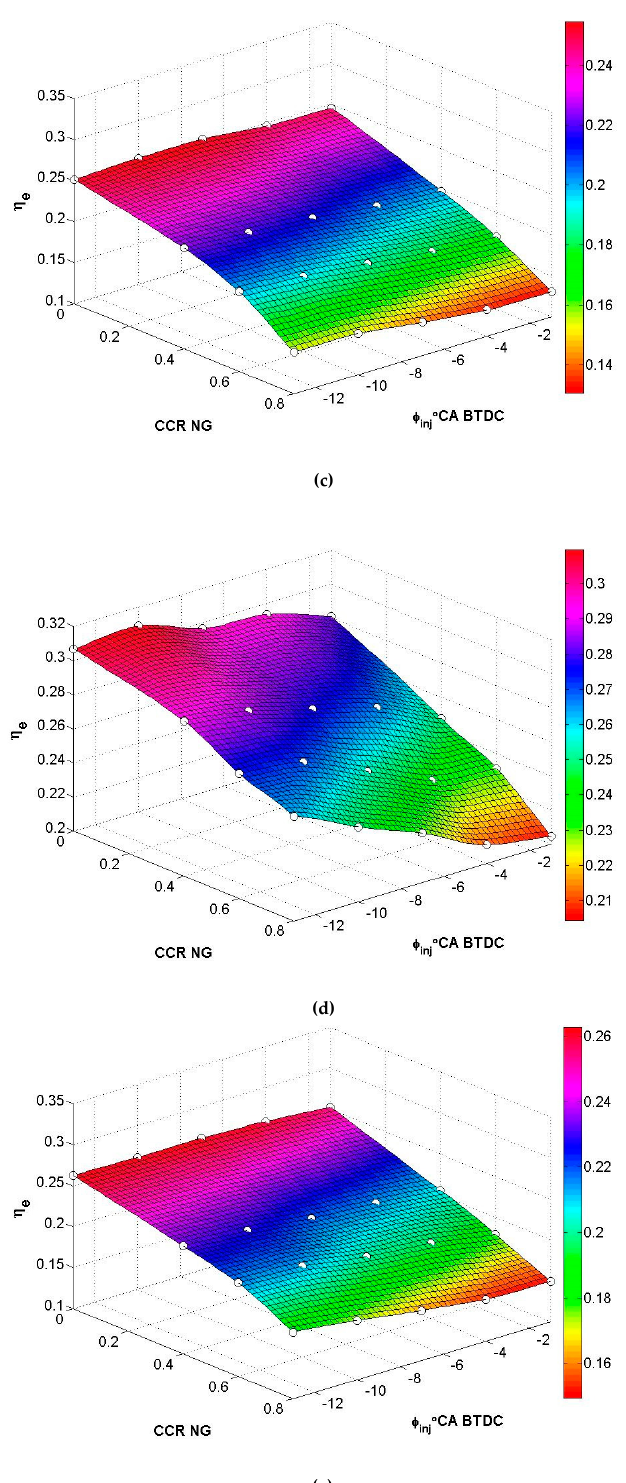
(cid:16) (cid:17) φ on engine η e at ( a ) HLM, n = 2000 min inj − 1 ; ( d ) MLM, n = 2500 min